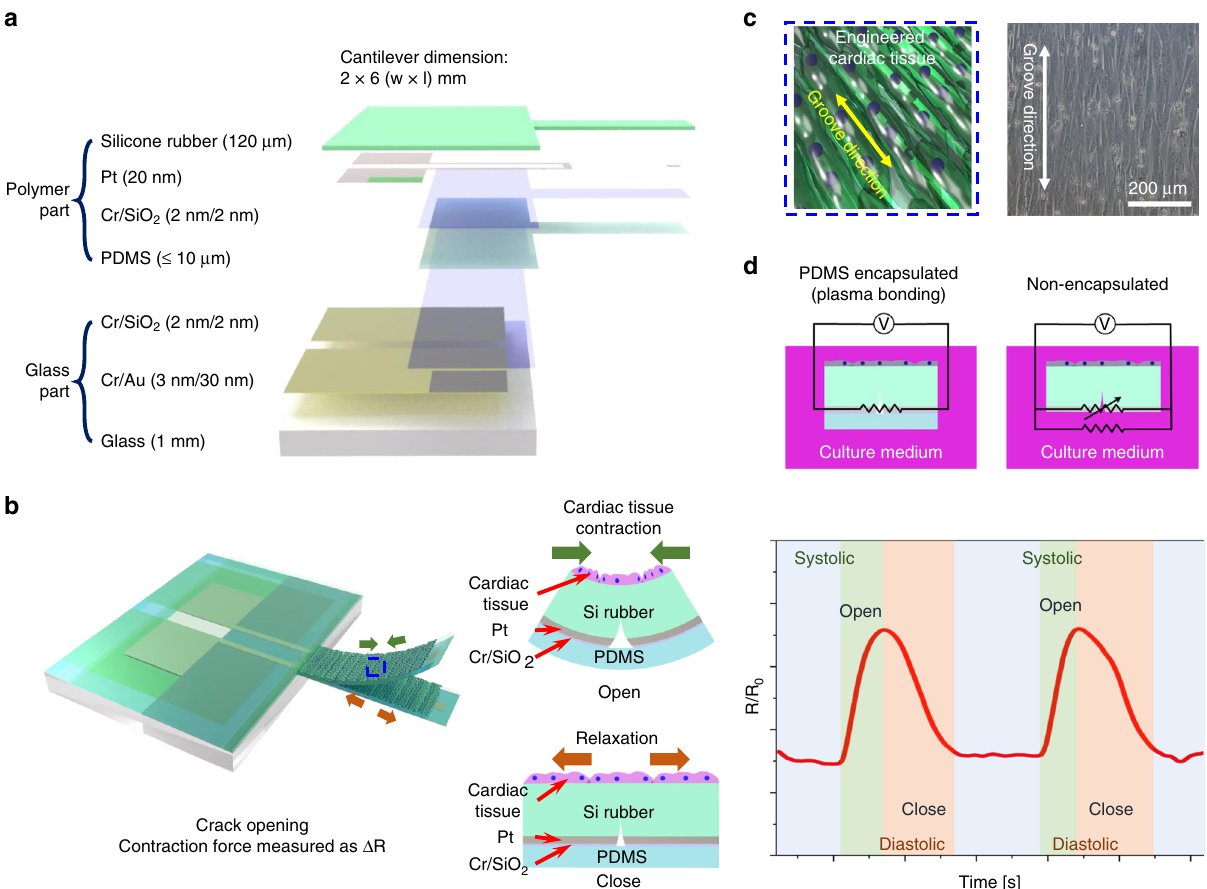
Fig. 1 Concept of the highly durable crack sensor working in culture media. a Dimensions of the PDMS-encapsulated crack sensor-integrated silicone rubber cantilever. b Schematic of a silicone rubber cantilever composed of various layers and operation principle of the cantilever sensor-integrated with a PDMS-encapsulated crack sensor to measure the contractile force of cardiomyocytes in liquids. c Nano-patterns used to align the cardiomyocytes on the cantilever surface. d Circuit diagrams of two different crack sensors operating in culture